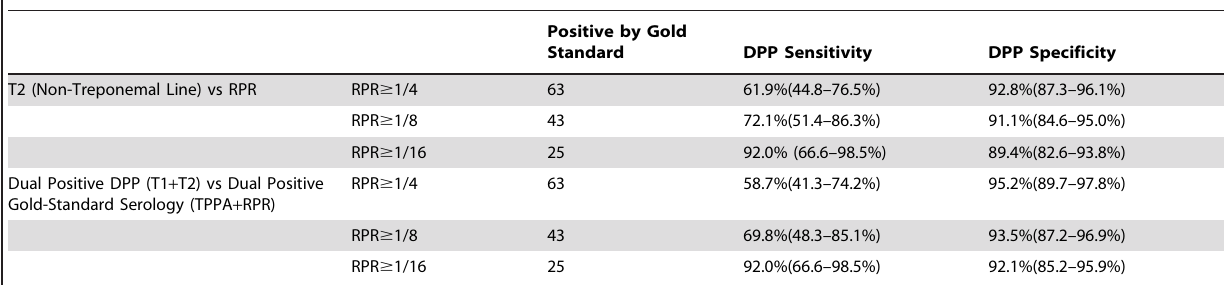
Table 3. Test characteristics by RPR titre.